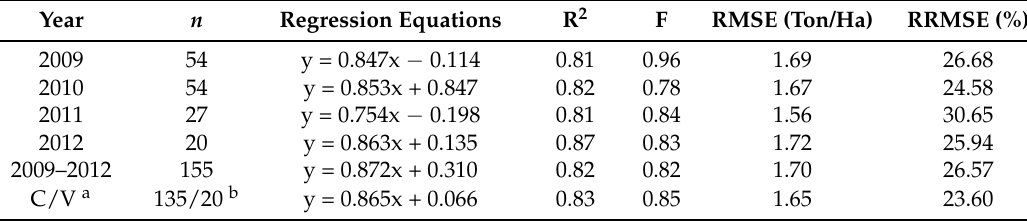
Table 6. Equations for regressions between data assimilation biomass ( BIOs ) and field measurement biomass ( BIOm ) of winter wheat for the four experiments. Year n Regression Equations R 2 RMSE